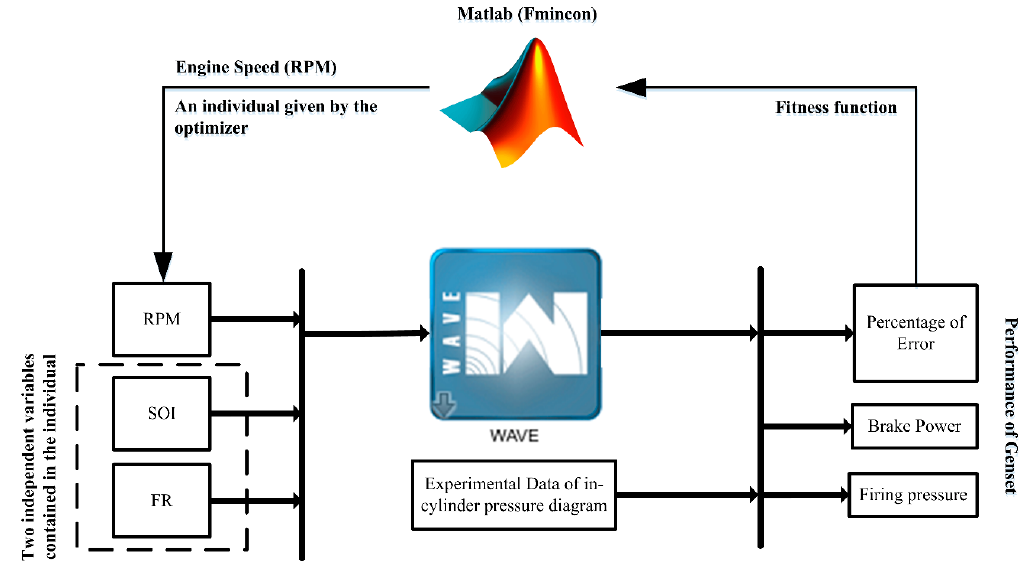
Figure 3. Engine optimization model.